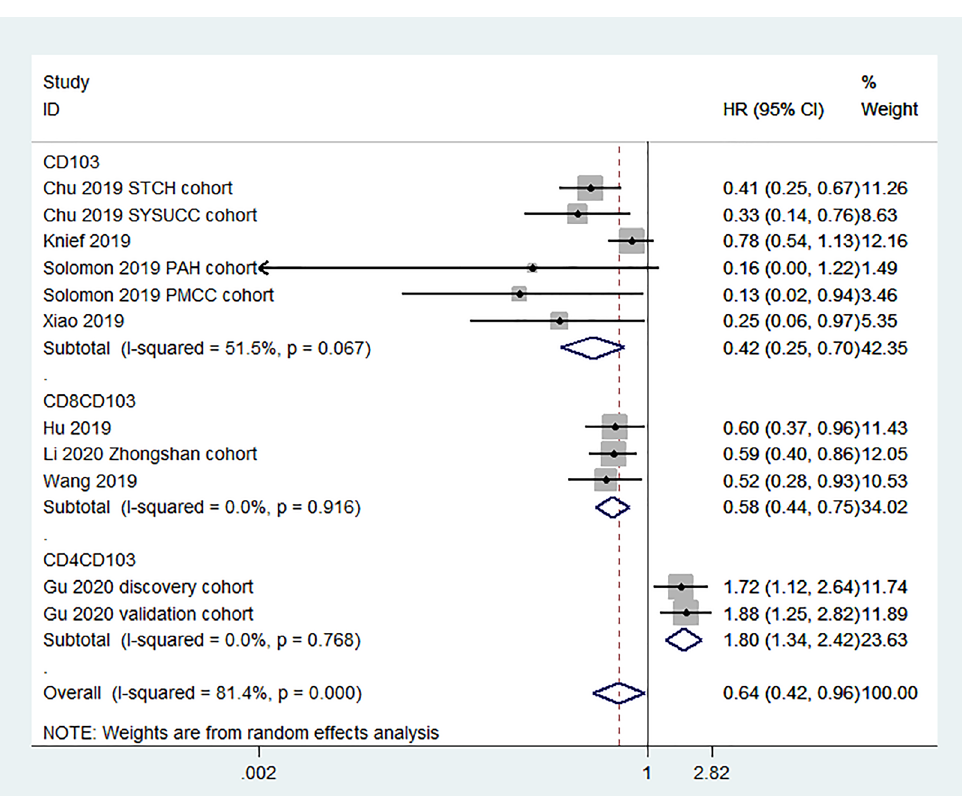
Fig. 4. Subgroup analysis by cell